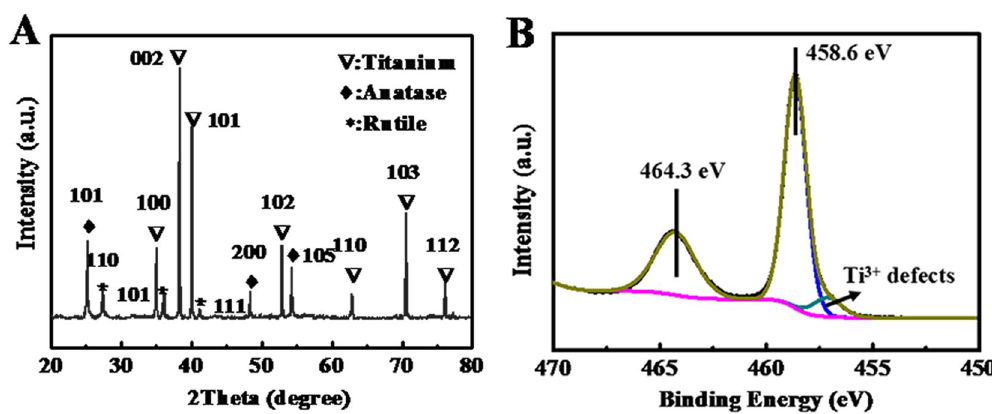
Figure 2. ( A ) XRD pattern and ( B ) Ti 2p XPS of the final structure fabricated by the proposed hybrid